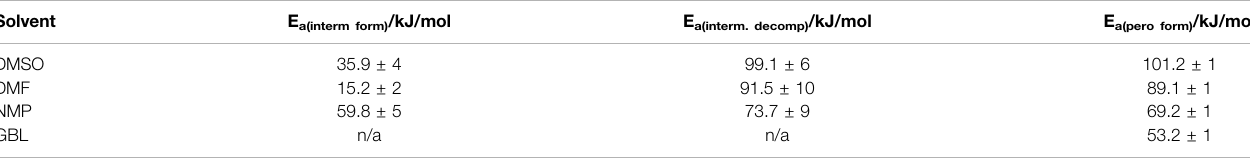
TABLE 1 | Calculated activation energies for the formation (E a(interm form) ) and decomposition (E a(interm. decomp) ) of intermediate phases and formation of perovskite phases (E a(pero form